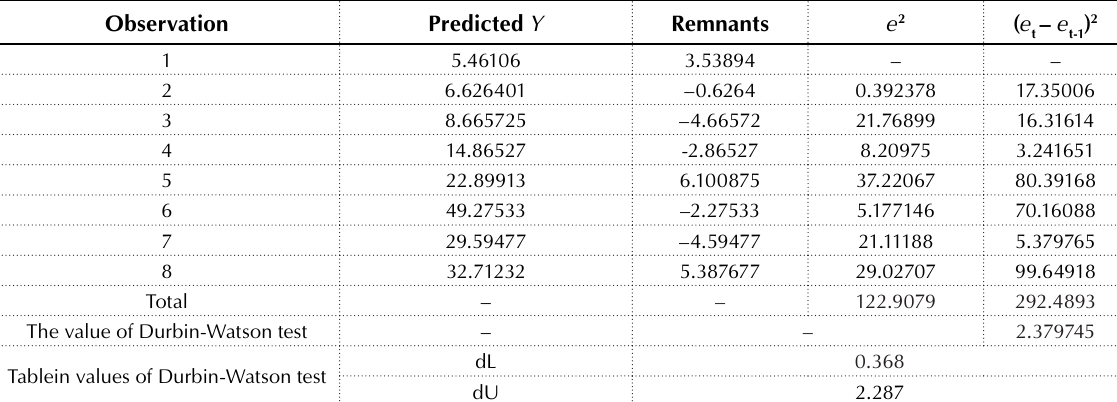
Table 4. Data for calculation of autocorrelation Observation